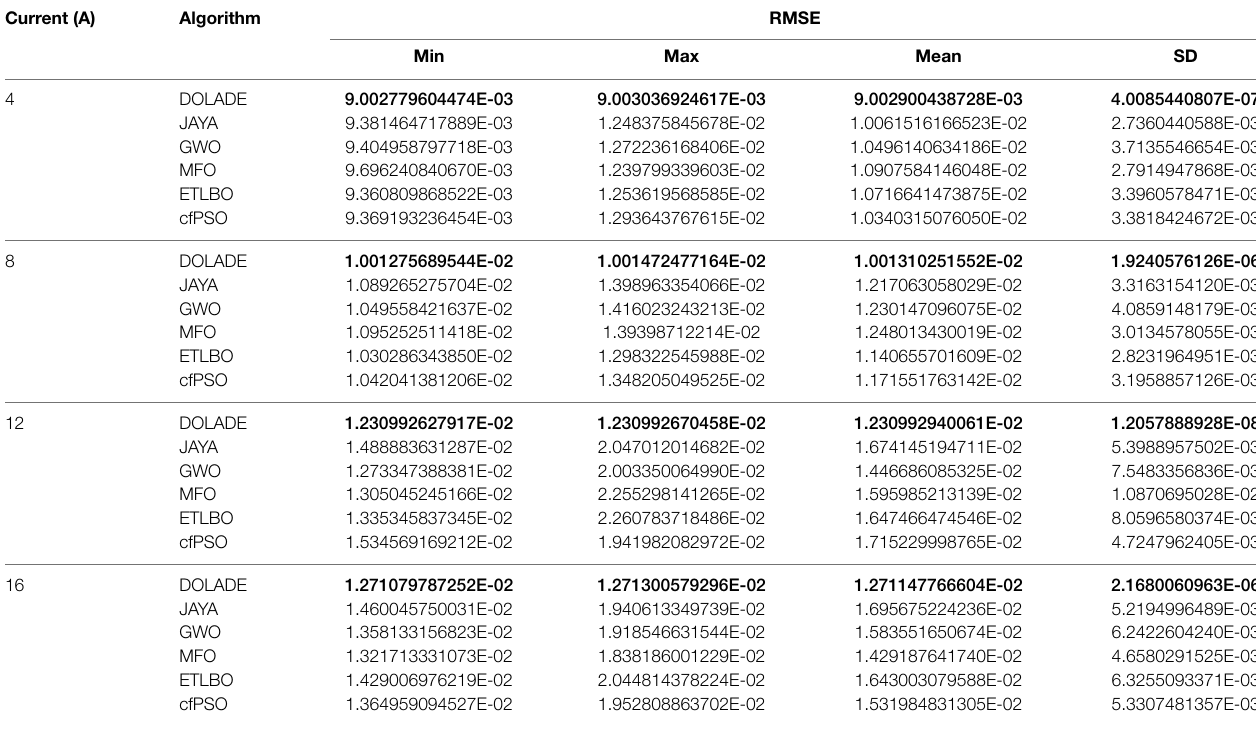
TABLE 5 | Statistical results of RMSE for six algorithms under different